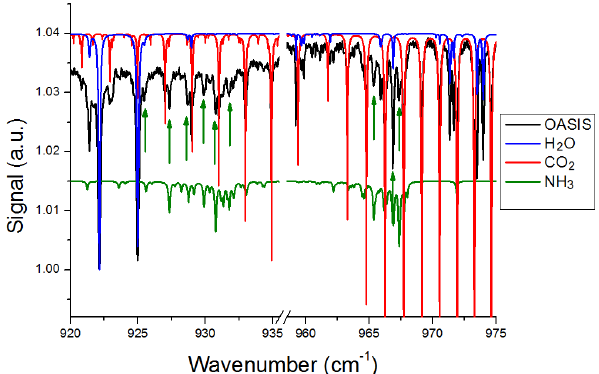
Figure 2. OASIS FTIR atmospheric spectrum recorded with the Bruker Vertex 80 at Créteil on 21 March 2012 in the two microwin- dows (before and after the spectral gap), showing the strong am- monia absorbing lines (pointed out by the green arrows) around 932 cm − 1 (origin of the NH 3 ν 2 band) with individual contribu- tions of the main interfering species represented from the atlas of Meier et al. (2004). All spectra are plotted using arbitrary unit (a.u.) on the y